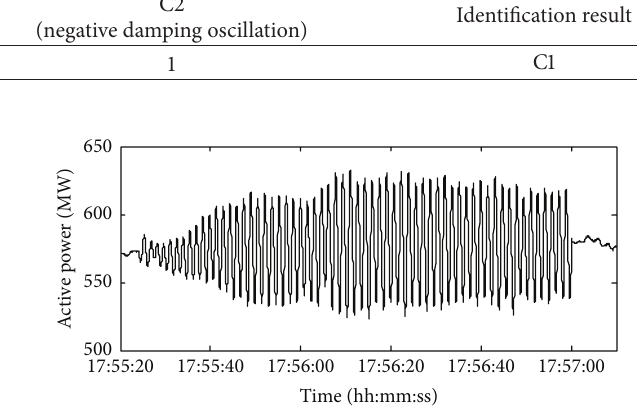
Figure 6: The active power oscilloscope record of Yao-Shao tie line.